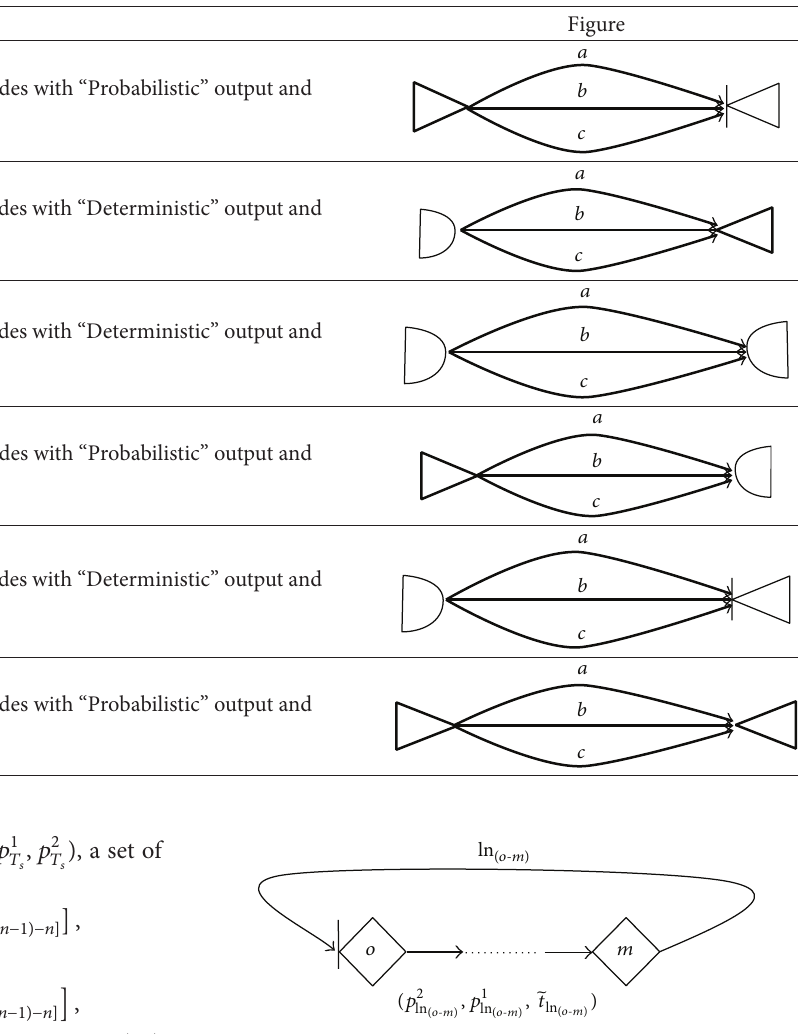
Figure 4: View of a loop